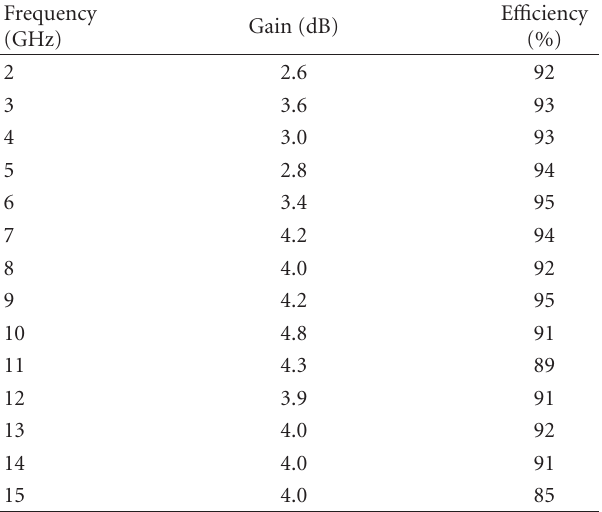
Table 1: Gain and e ffi ciency simulated results of textile uwb antenna